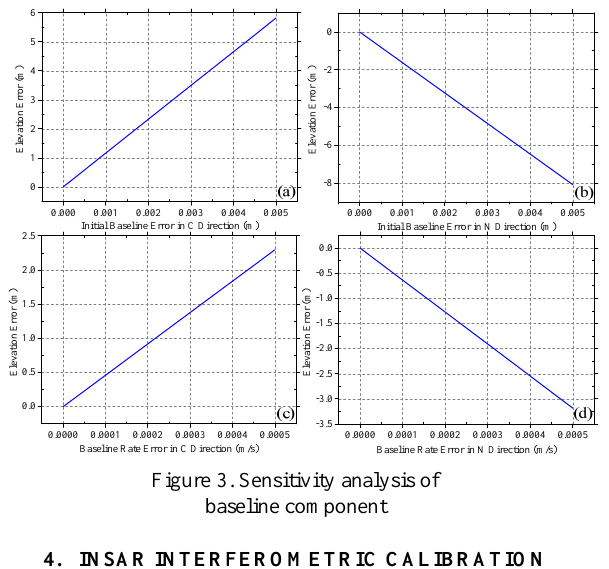
Figure 3. Sensitivity analysis of baseline